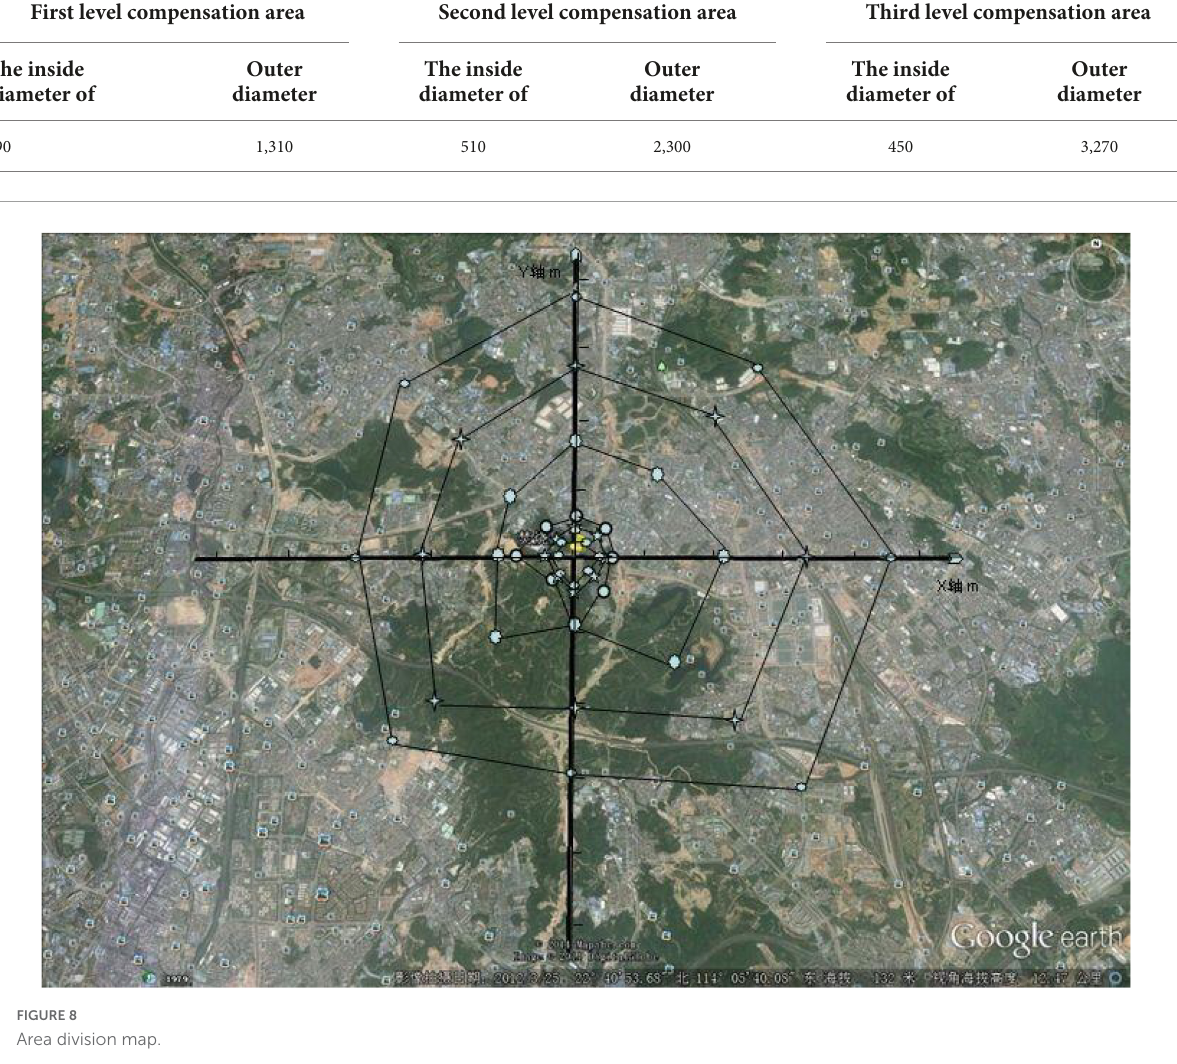
TABLE 19 Compensation area division in the NW direction.